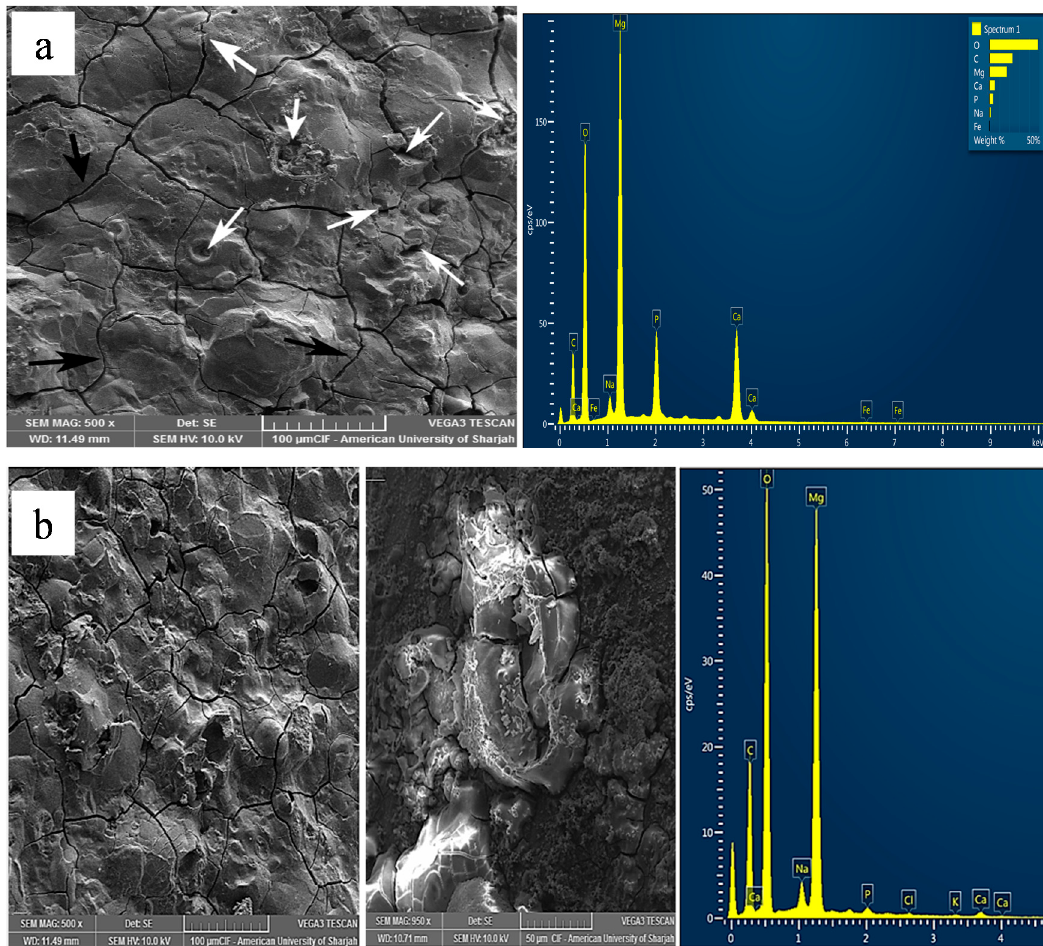
Figure 5. Representative micrographs of corroded surface for ( a ) pure Mg and ( b ) Mg-1.0SiO 2 in ABPS medium.